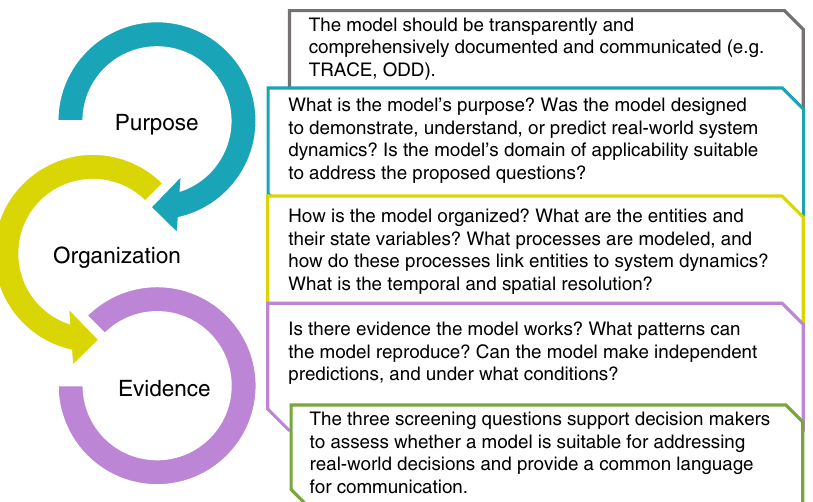
Fig. 1 Three screening questions on a model ’ s purpose, organization, and evidence. They support the assessment of whether a model is suitable for addressing real-world decisions and how to use model results. They provide a common language for modelers and decision makers. They help to evaluate models and take them into account according to their purpose and evidence (TRACE: TRAnsparent and Comprehensive model “ Evaludation ” 8 ); ODD: overview, design concepts, details 10